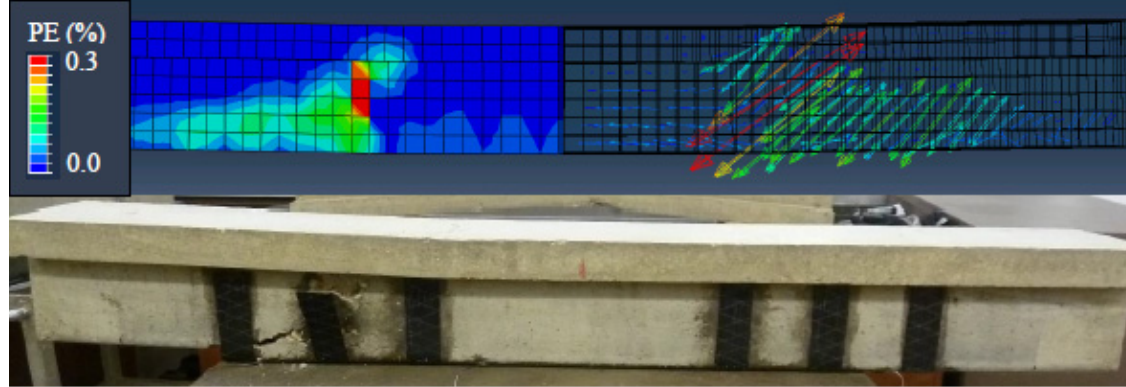
Figure 14. Comparison of cracking and plastic strain between model and experiment for S1-FRP1s.